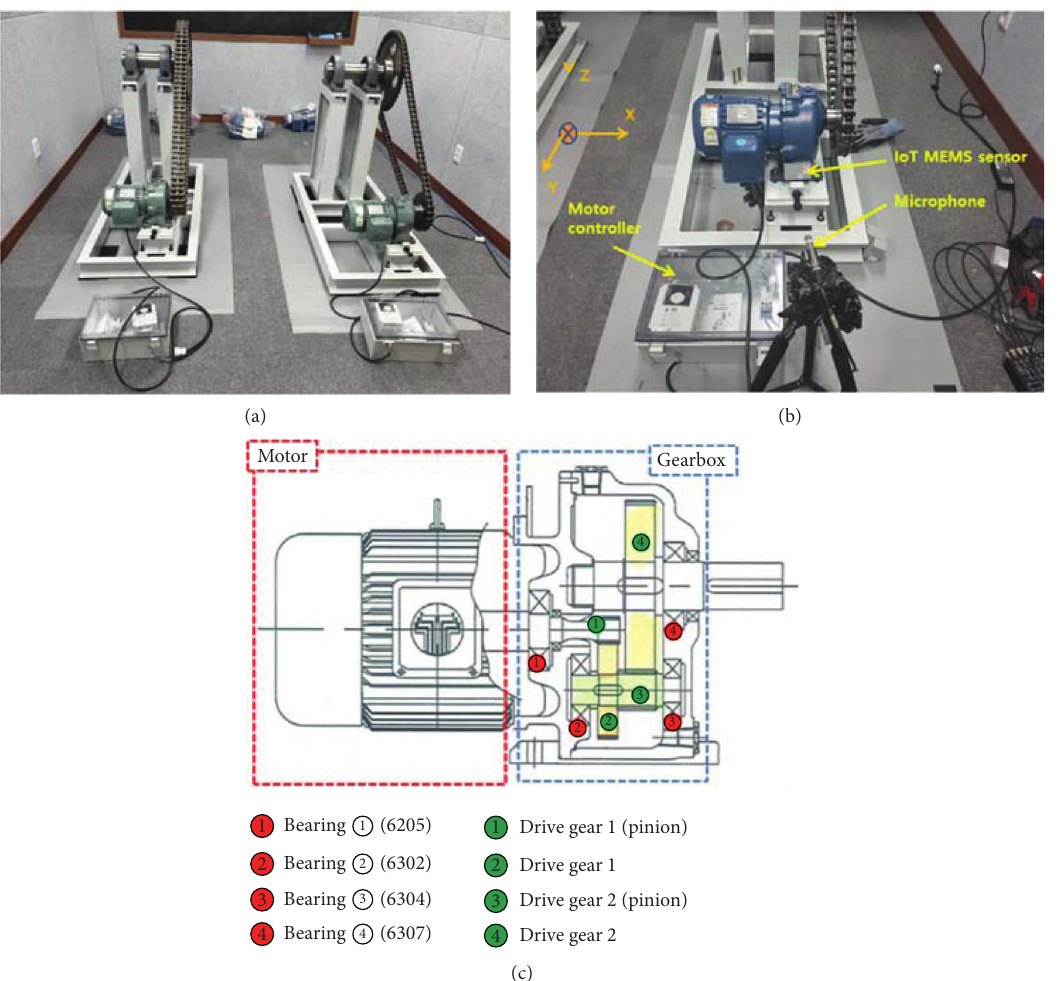
Figure 2: Visualization of the CSD system and sensors used for experimentation: (a) total view; (b) sensor positions; (c) motor, bearings, and gearbox.